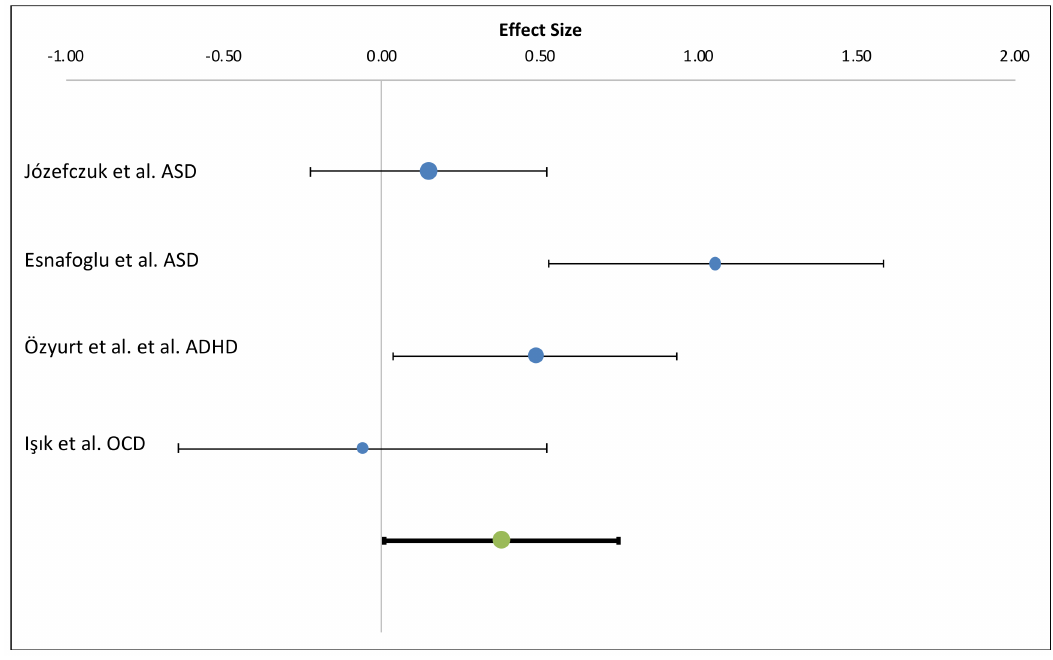
Figure 2. Forest plot showing the individual mean di ff erences among cases and controls for each of the four studies and the combined estimate from a fixed-e ff ect model (bottom, p = 0.001). The E ff ect estimates are presented as Cohen’s d with positive e ff ect size indicating higher zonulin levels among cases compared to